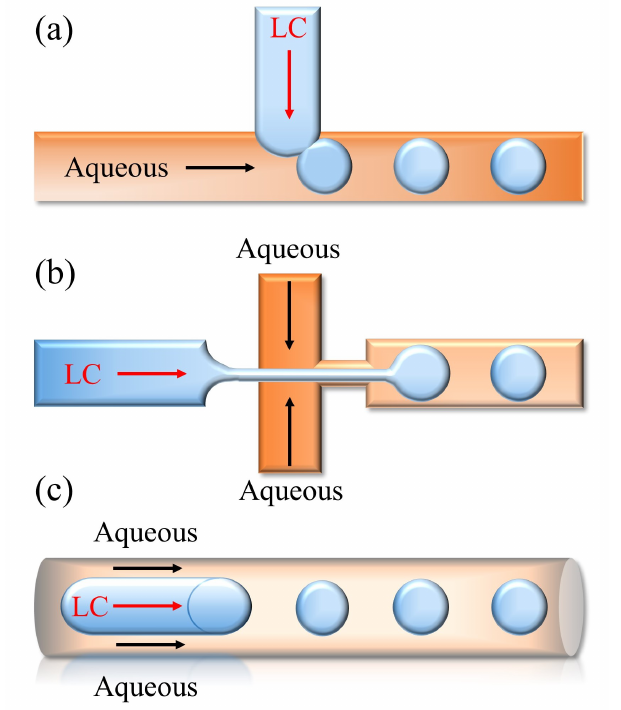
Figure 8. LC droplets generation strategies: ( a ) T-junction structure; ( b ) flow-focusing structure; ( c ) co-flowing